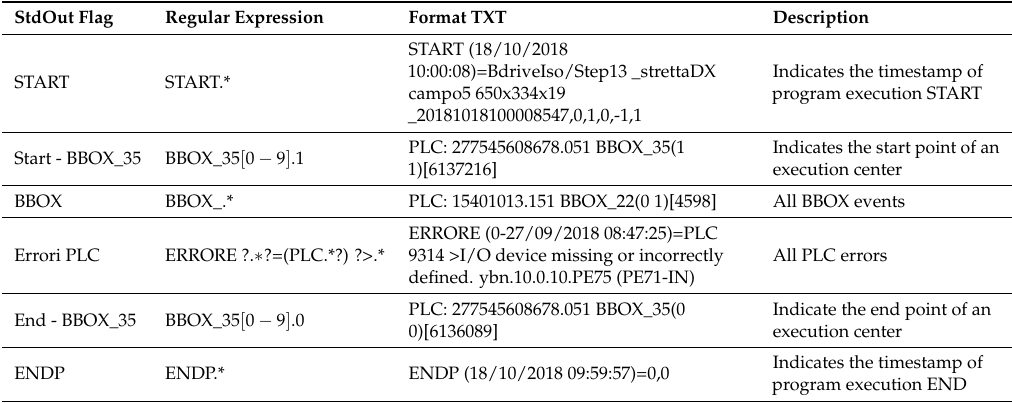
Table A1. StdOut flag